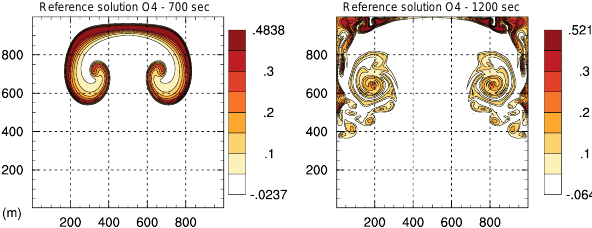
Figure 16. Rising thermal bubble potential temperature reference solution at vertical order 4. Reference resolution (cid:49)x = 5m and (cid:49)z = 5m. Flow at 700 and 1200s. Contour interval: 0 . 05K. cients in are given